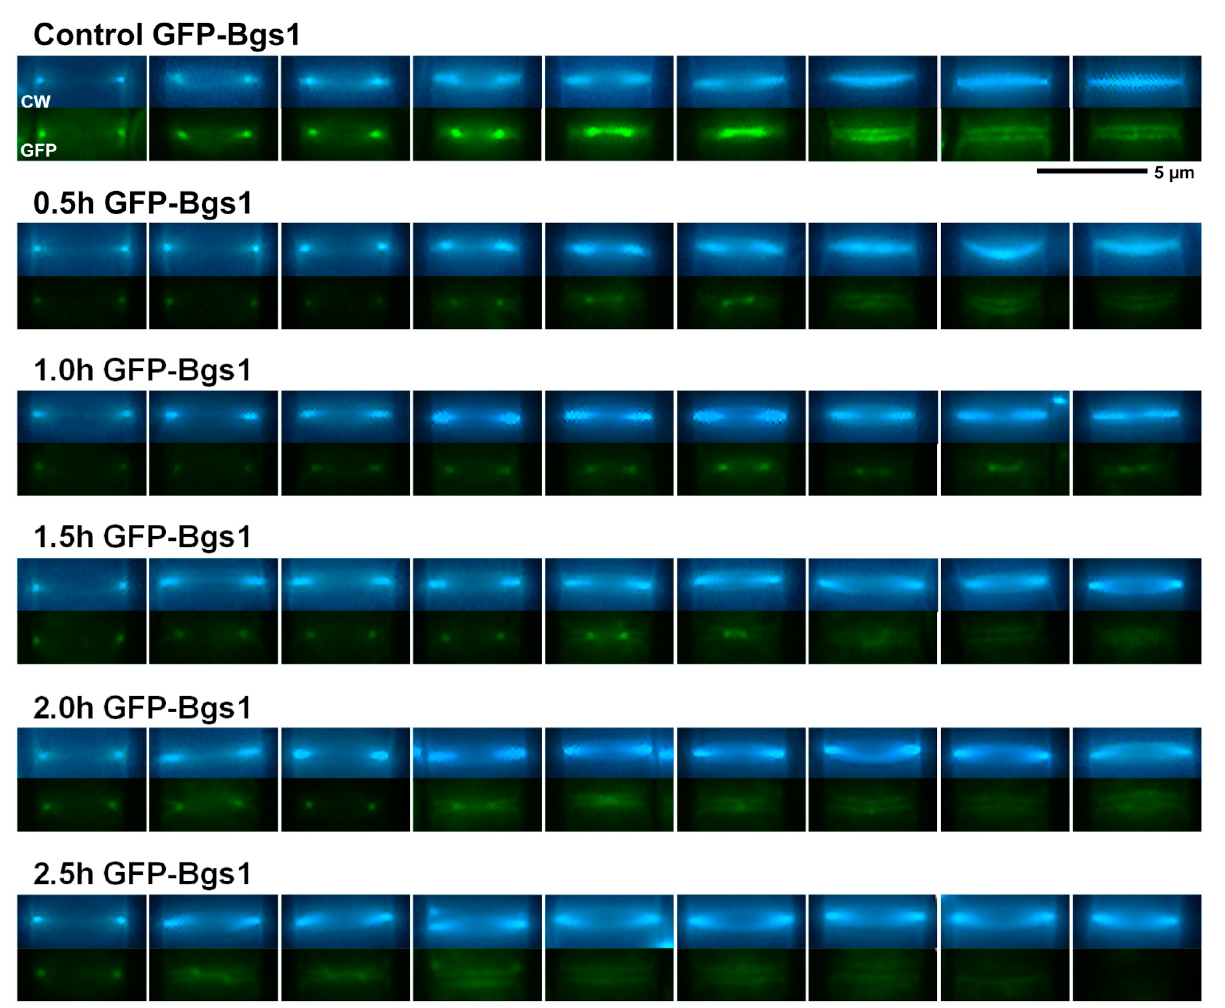
CW ‐ stained GFP ‐ bgs4 + cells. Cells were grown as in Figure 2 and imaged at the indicated times using phase ‐ contrast and CW and GFP fluorescence microscopy either in the absence (( A ): control) or in the presence of sublethal (( B ): 2 μ g/mL; ( C ): 4 μ g/mL) or lethal (( D ): 10 μ g/mL; ( E ): 20 μ g/mL) doses of the antifungal. Scale bars: 10 μ m.